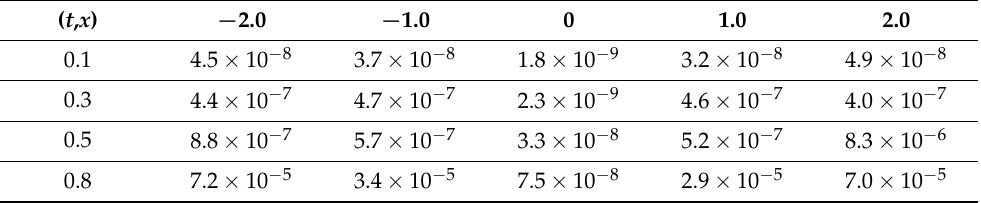
Figure 3. ( Above ) Three-dimensional illustrations of the numerical simulation and exact solution, and two-dimensional illustration of the approximation of | u | 2 ; ( Below ) three-dimensional illustrations of the numerical simulation and exact solution, and two-dimensional illustration of the approximation of | v | 2 for Case C. Table 3. Case C: Absolute error for different values of ( x , t ) considering N = 15 steps.